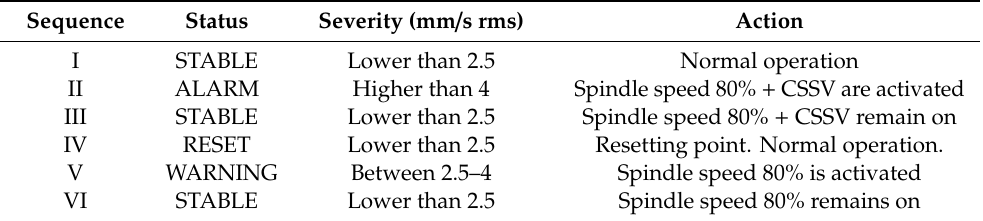
Table 4. Algorithm action